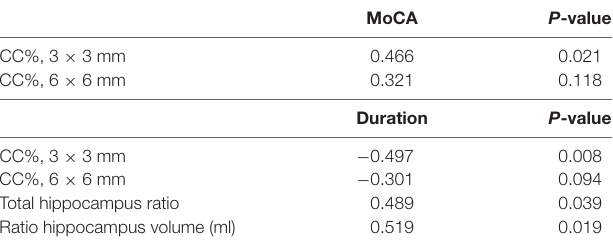
TABLE 4 | Correlation between choriocapillaris densities, MRI variables and clinical variables.